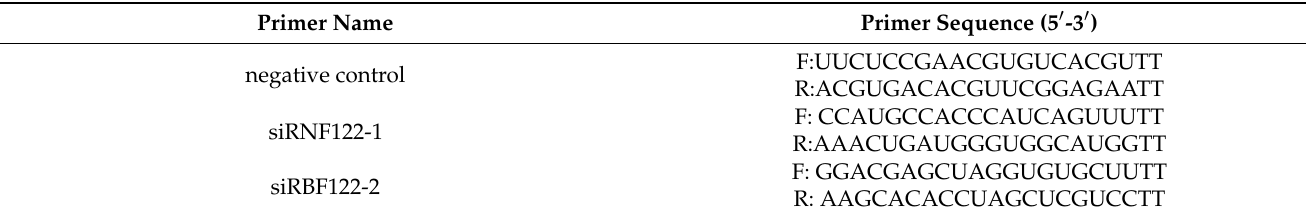
Table 2. Primers used in small RNA interfering